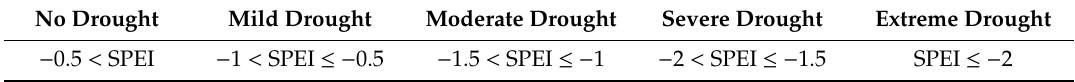
Table 1. Classifications of drought magnitude based on SPEI